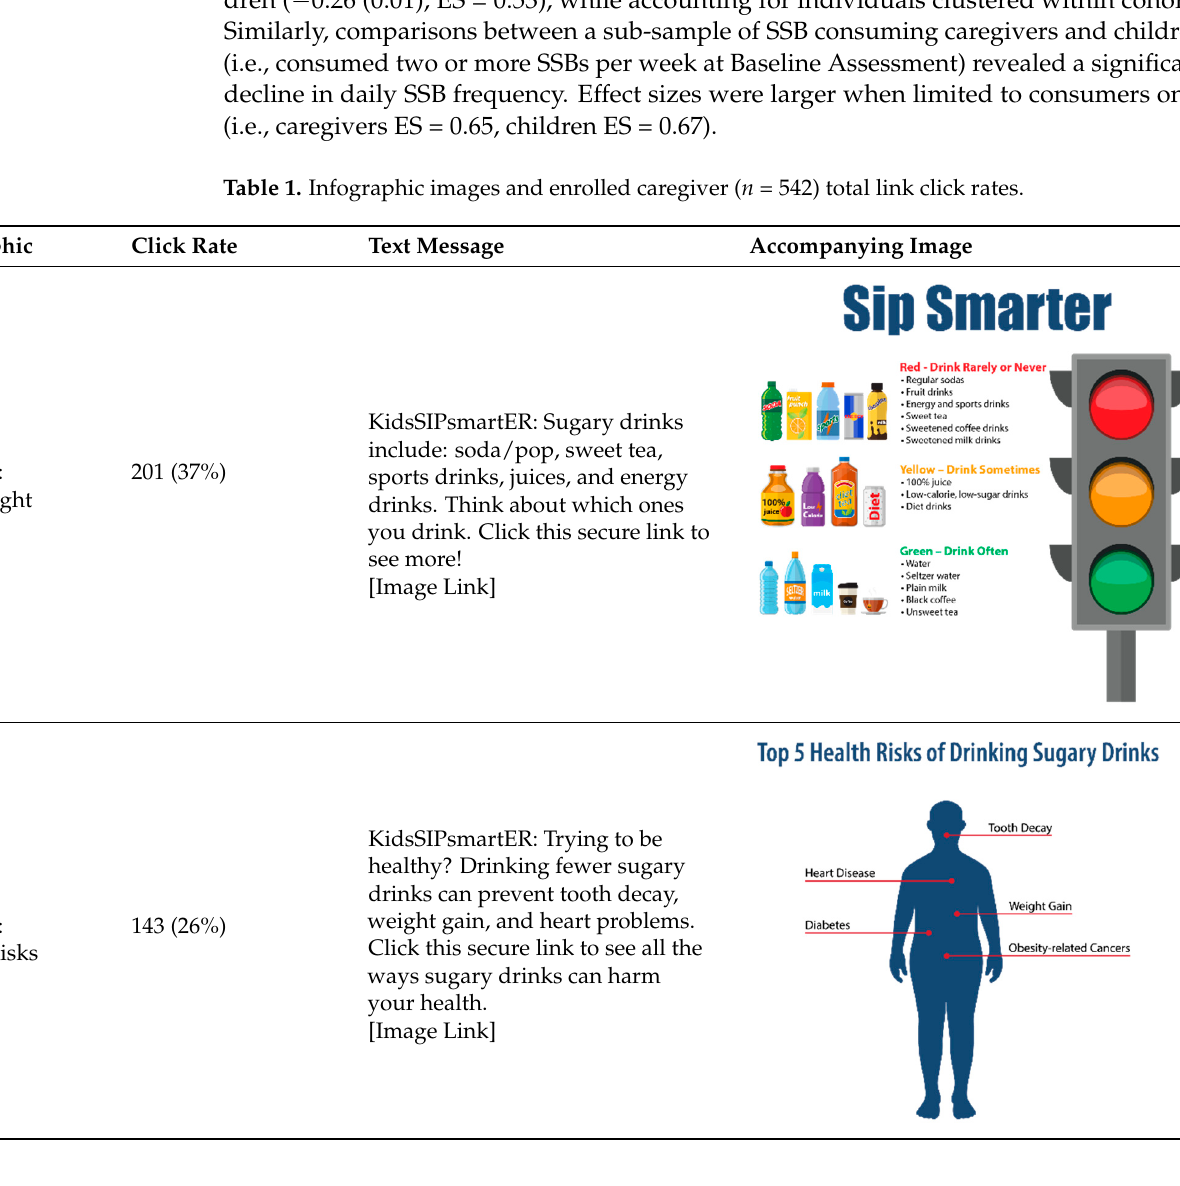
Figure 4. Strategy selections made by enrolled caregivers ( n = 542) from Baseline 1 through Assess- ment 4 2 . 1 At the Baseline Assessment, 14 (3%) of the “no strategy selection” caregivers were those who completed the Baseline Assessment at the second a tt empt (during Assessment 2), and their strategy selections are included in the Assessment 2 data (Home/shopping tips = 3, Breaking the Partial responder = 1). 2 Caregivers do not select a strategy at Assessment 5.